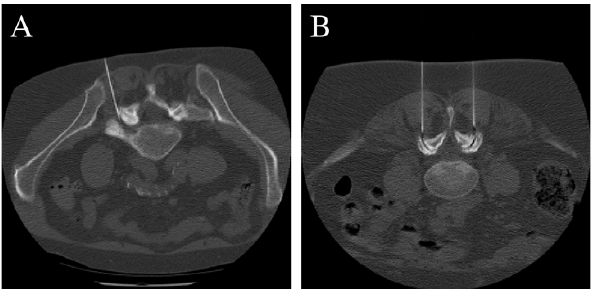
Figure 1. Computed tomography showing the positioning of the spinal needle(s) lateral to the midline at the level of the affected nerve root via an extraforaminal approach at the L5/S1 neuroforamen ( A ) and L4/5 facet joint ( B ).